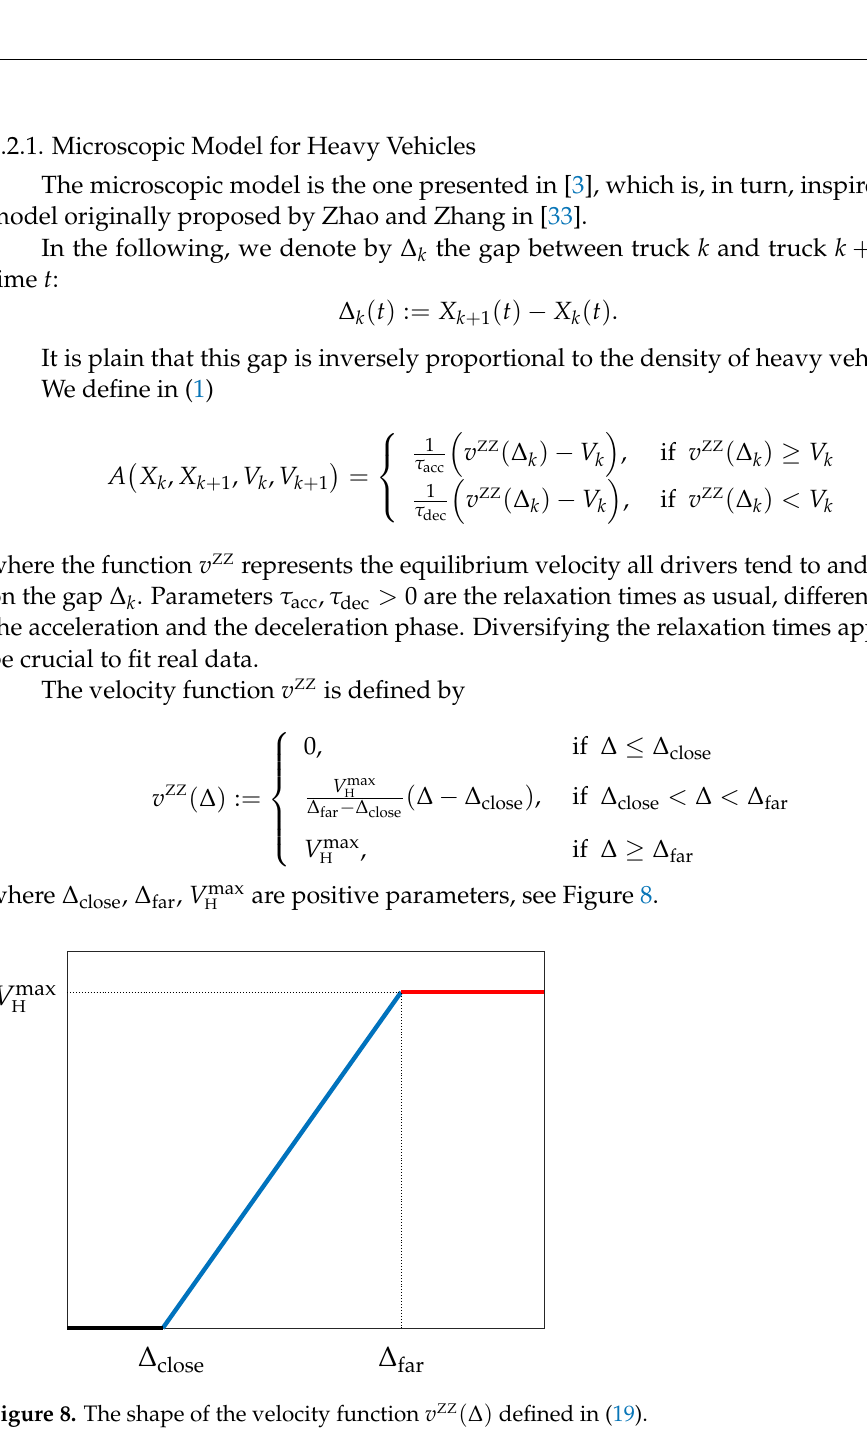
Figure 8. The shape of the velocity function v ZZ ( ∆ ) defined in (19).